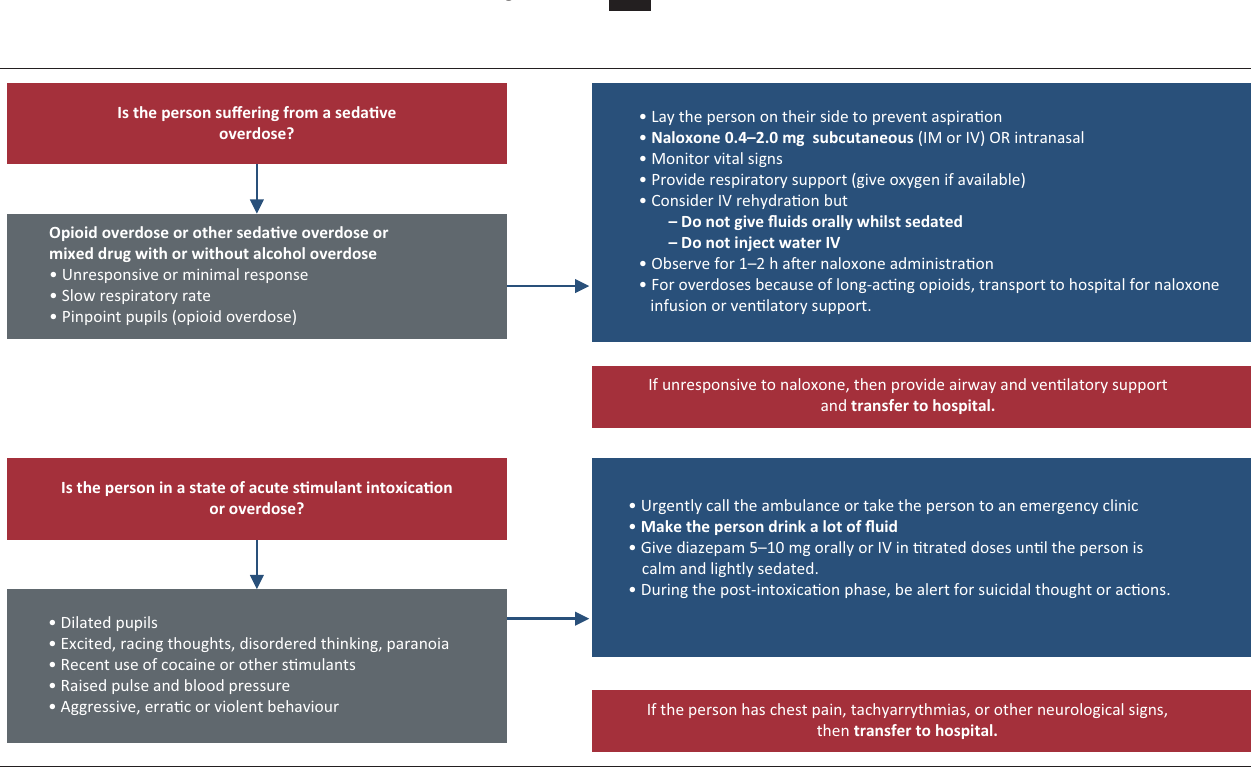
Opioid overdose or other seda(cid:13)ve overdose or mixed drug with or without alcohol